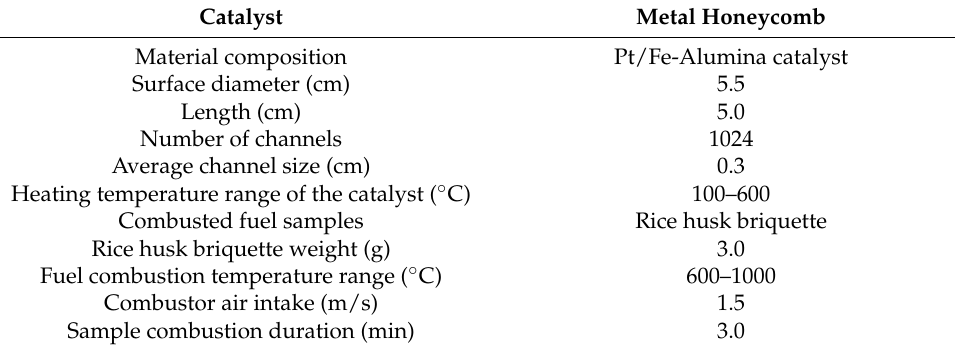
Figure 2. Experimental setup showing the exhaust system integrated with the metal honeycomb catalyst. Table 1. Experimental conditions and catalyst specifics.